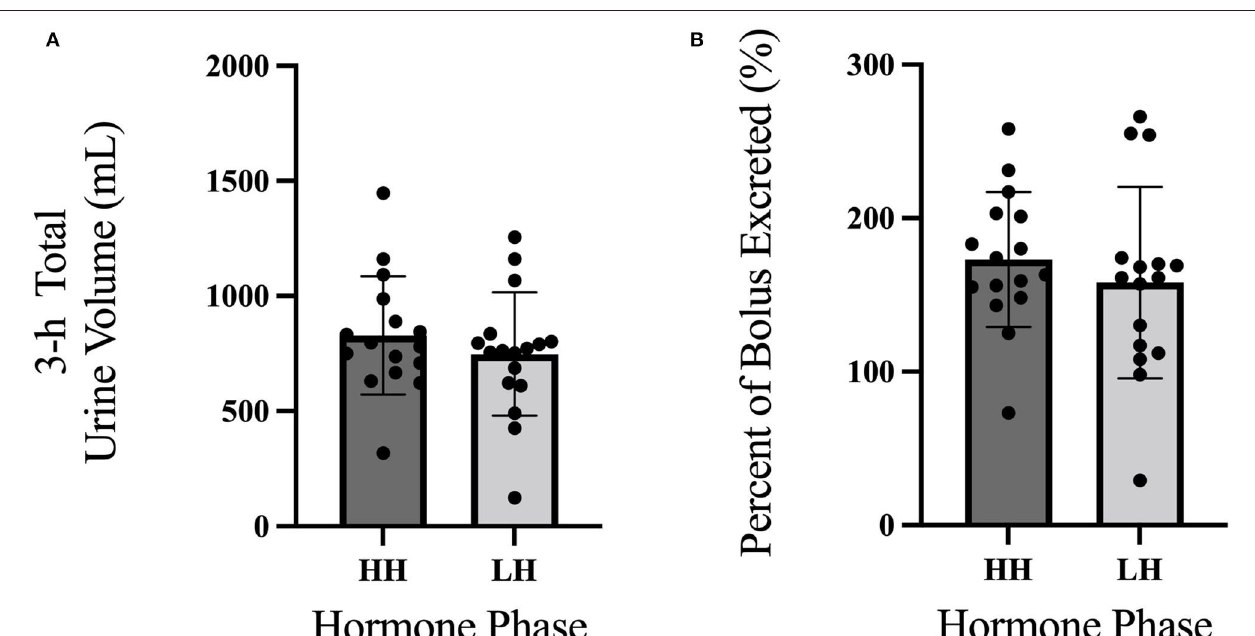
FIGURE 1 | 3-h urine volume responses to an acute water bolus. (A) Between trials, there were no differences in 3-h total urine volume ( P = 0.296). (B) There was no difference in the percentage of bolus excreted over 3-h between trials ( P = 0.104).